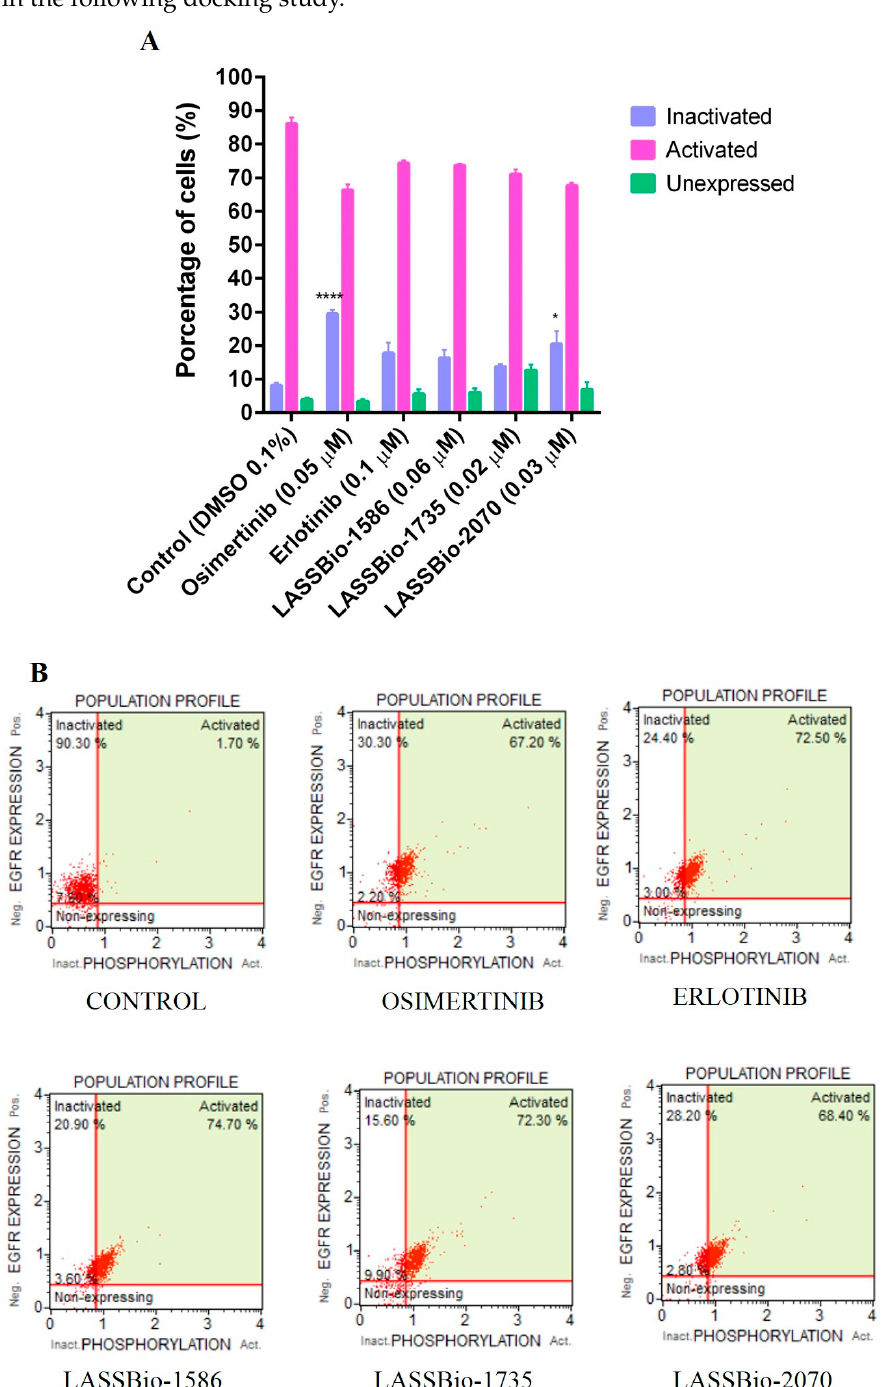
Figure 5. Determination of EGFR inhibition capacity in a PC-9 cell line (EGFR L858R ) at 24 h. ( A ) Graphic representation of EGFR inhibition assay in a PC-9 cell line and with the respective percentages of cells containing activated, inactivated, and unexpressed EGFR. ( B ) Histograms from flow cytometry with demonstrative values. Evaluation of the cell cycle on PC-9 (EGFR L858R ) at 24 h analyzed with a MUSE™ cell analyzer and compared to the control group. The data are presented as mean values ± SD, obtained by at least three independent experiments performed in triplicate, the data compared with the negative control by ANOVA followed by a multiple comparisons test in all phases with * p <0.05 and **** p < 0.0001.